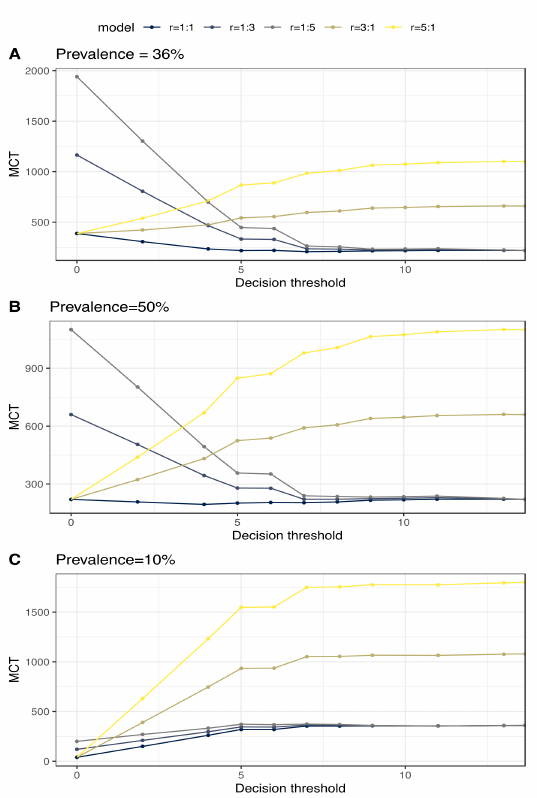
Figure 5. Misclassification cost-term (MCT) analysis of a specific score to determine lung consolida- tion. The same dataset as in Figure 3 was used to determine the misclassification cost term using: ( A ) the original prevalence of the target condition in the dataset (36% of calves were detected with ultrasonographic lung consolidation depth ≥ 1 cm); ( B ) a prevalence of 50%; and ( C ) a prevalence of 10% based on internal resampling. Different false negative (FN): false positive (FP) cost ratios ( r) are indicated. In the first scenario, r was considered as 1:1, meaning that FN and FP had the same impact. Two scenarios where FN calves were considered more costly than FP calves with 3:1 and 5:1 r